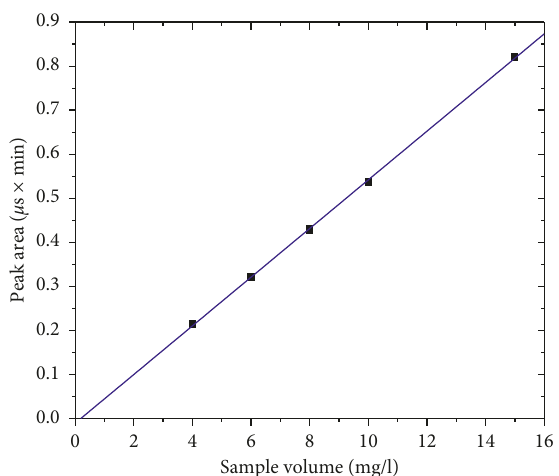
Figure 2: Calibration curve for the chloride content measurement.